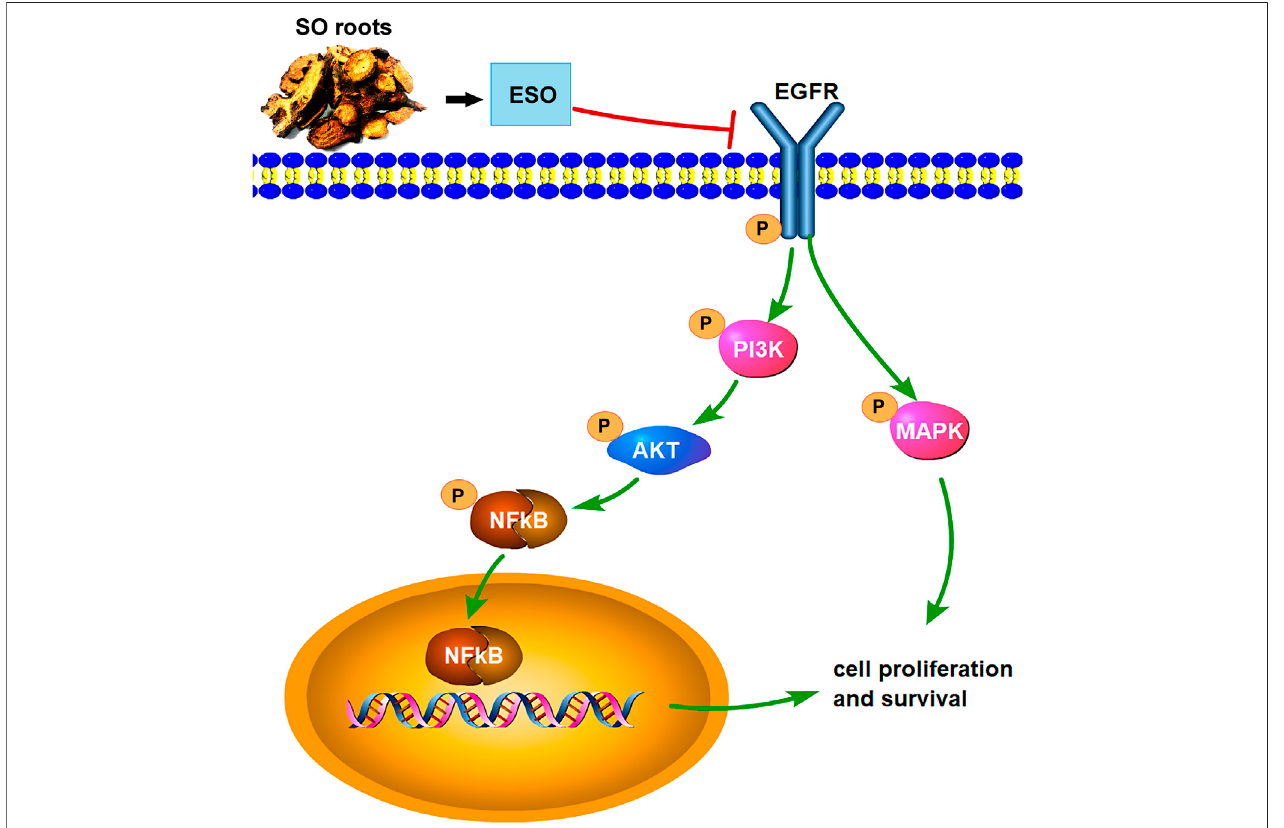
FIGURE 10 | The overview of the regulatory mechanism involved in the anti-cancer effect of SO on HCC.